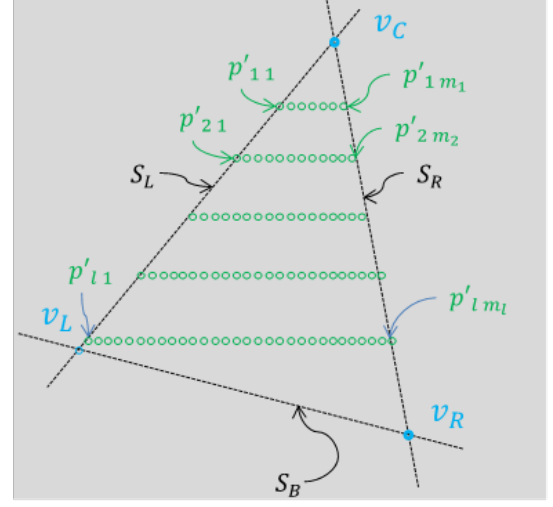
Figure 8. Vertices, adjacent lines, and projected points on the triangle